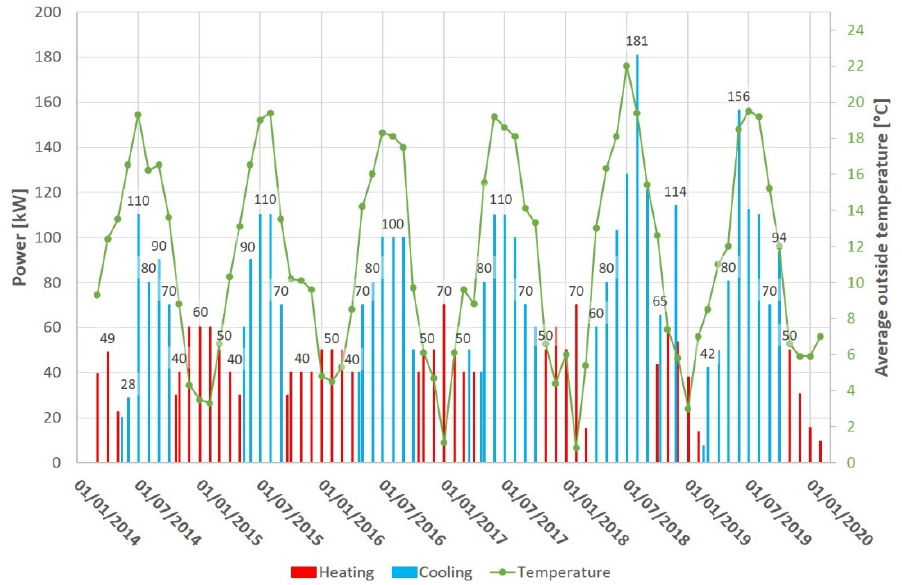
Figure 6. Monthly heating and cooling powers derived from groundwater by the ATES system of Building n° 1.